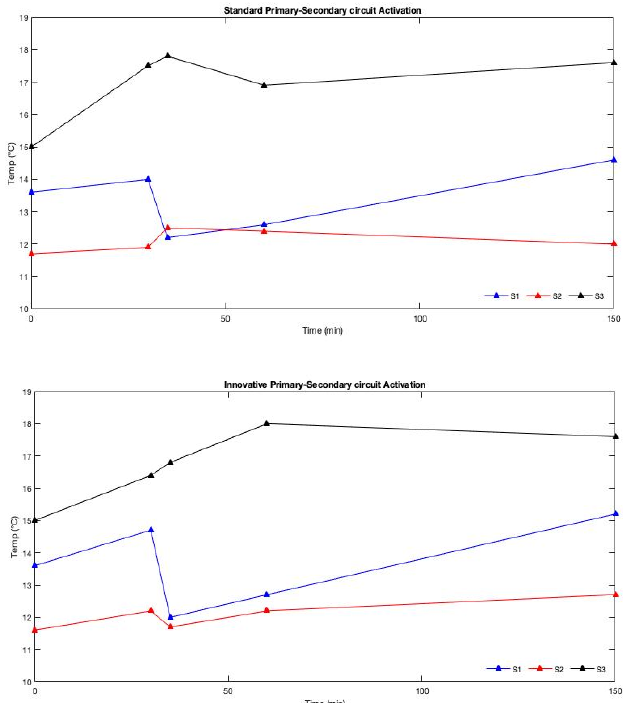
Figure 9. S1, S2 and S3 measurements in standard and innovative configuration during the primary-secondary circuits tests.